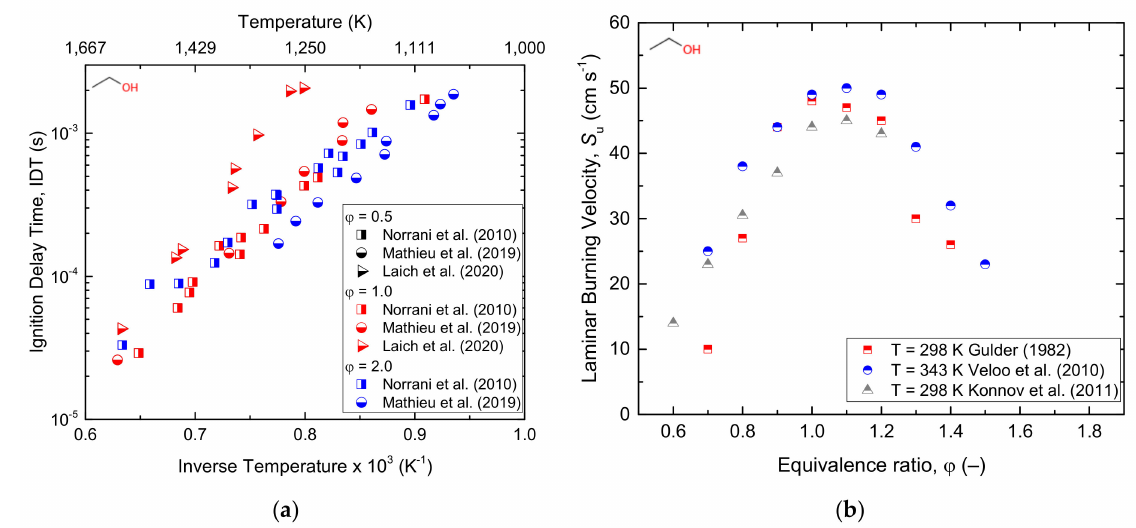
Figure 5. Ignition delay time ( a ) and laminar burning velocity ( b ) of the ethanol/air mixture under different conditions.